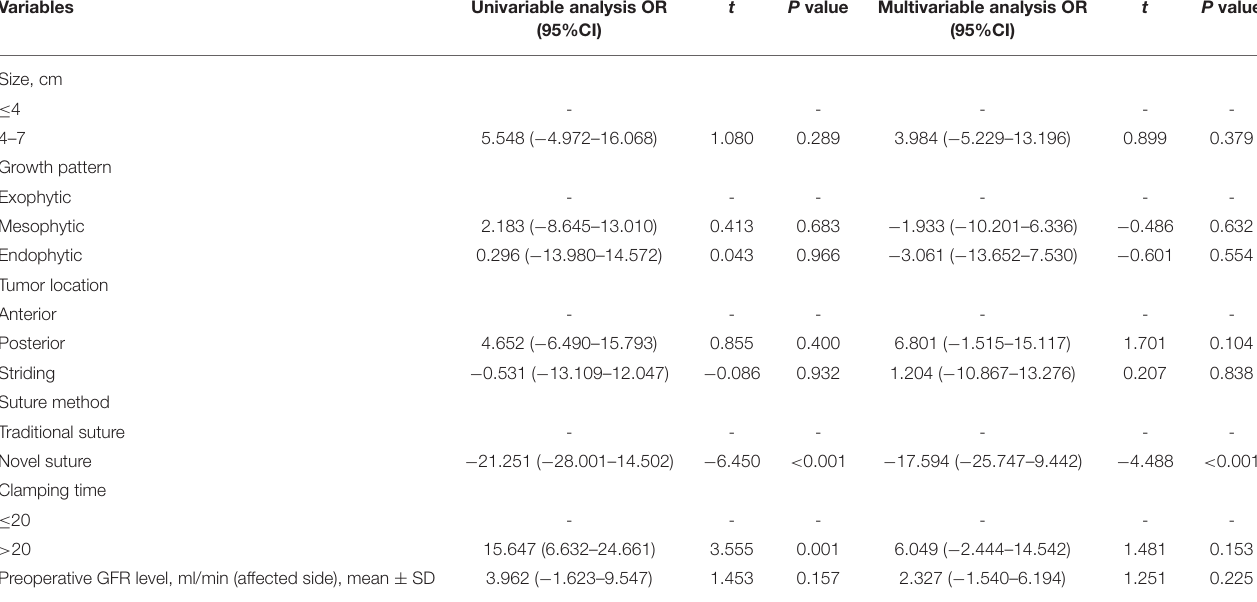
TABLE 4 | Univariable and multivariable associations with reduction in glomerular filtration rate. Variables